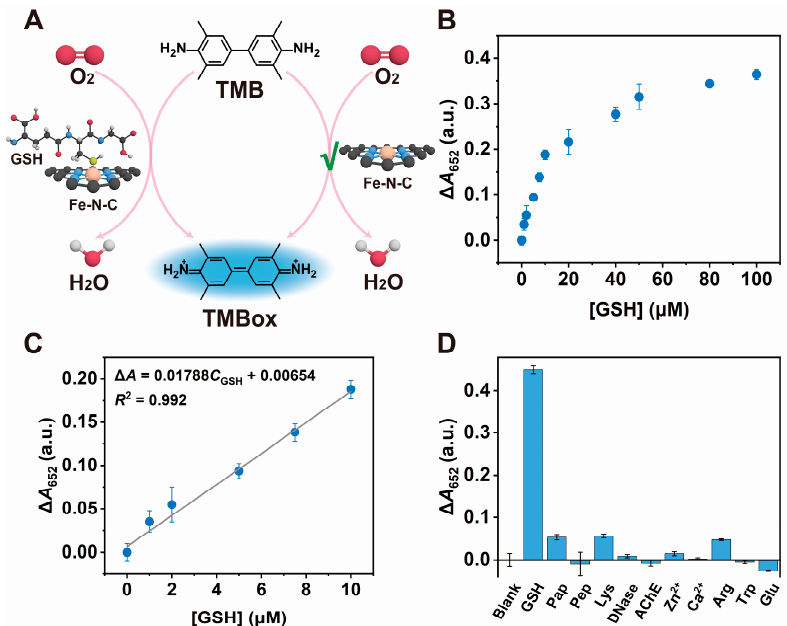
Figure 5. Colorimetric detection of GSH based on its inhibitory e ff ect. ( A ) Schematic illustration of the GSH-sensing principle. ( B ) Relationship between the relative absorbance at 652 nm ( Δ A 652 ) and the concentration of GSH. ( C ) Linear calibration plot for GSH detection. ( D ) Selectivity test. Con- centrations of the interferents: 100 µM GSH, 25 mM Zn 2+ and Ca 2+ , 10 mM Arg, Try, and Glu, and 2.5 U mL − 1 Pap, Pep, Lys, DNase, and AChE.